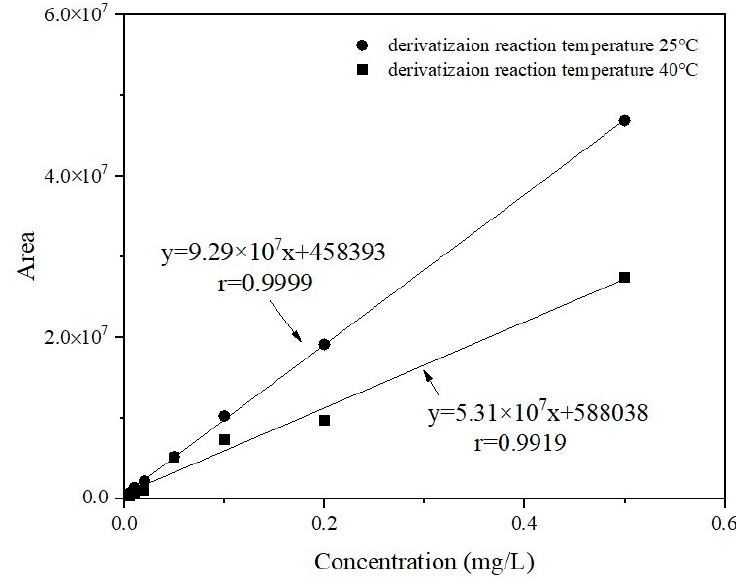
Figure 1. The working curves of GLUF-P at 25 °C and 40 °C. All three series of GLUF-P standard solutions from 0.005–0.5 mg/L were derivatized by different reaction times to attain the optimum reaction period. The results are shown in Figure 2. The peak areas of the derivatives corresponding to the same concentration of GLUF-P were similar at 1 h, 2 h, or 3 h, which suggested that the concentrations of the derivatives did not increase significantly after 1 h. Therefore, 1 h was the optimum reaction period. The chromatograms of the derivatives of the control and 0.1 mg/L GLUF-P standard solutions are shown in Figure 3a,b, respectively, and the retention time of GLUF-P derivatives was within 15–17 min.